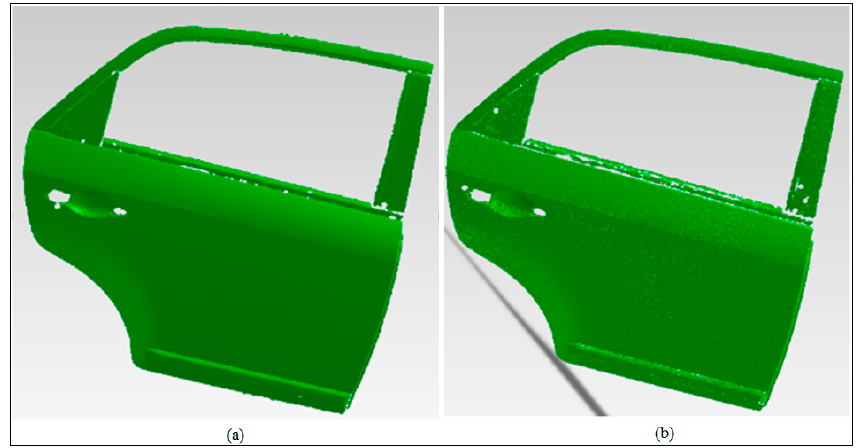
Figure 9. Data points obtained using white light scanner—( a ) best model; ( b ) worst model.